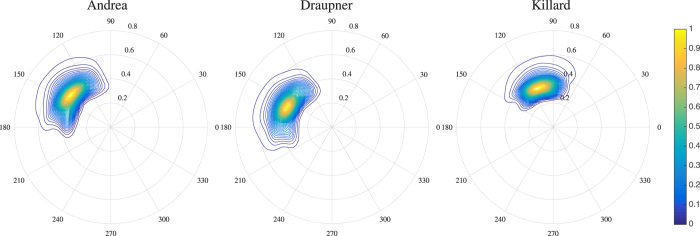
WAVEWATCH III hindcast directional wave spectra S(ω, θ) used as input for the HOS simulations.Here, ω is the angular frequency and θ the direction in degrees. (Left) Andrea, (center) Draupner, (right) Killard. The spectra have been normalized with respect to spectral peak values.